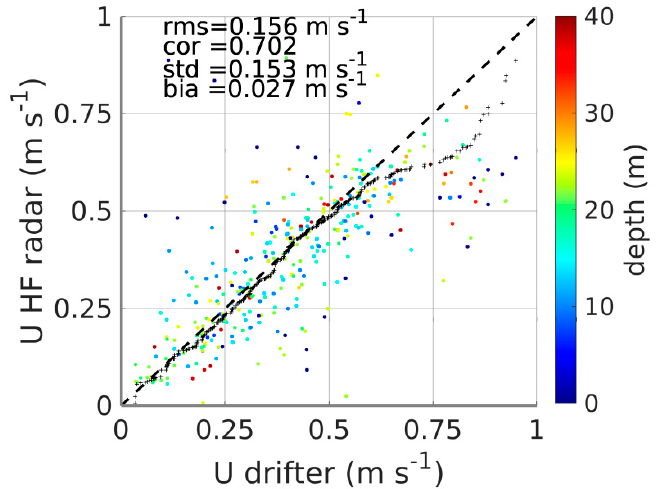
Figure 2. Velocity scatter plots: drifter versus HF radar velocity magnitude (m/s). The black dots indicate the quantile–quantile ( q - q ) plot. The black dashed line is the diagonal. The model topography is also interpolated to the drifter positions and depicted with colors.